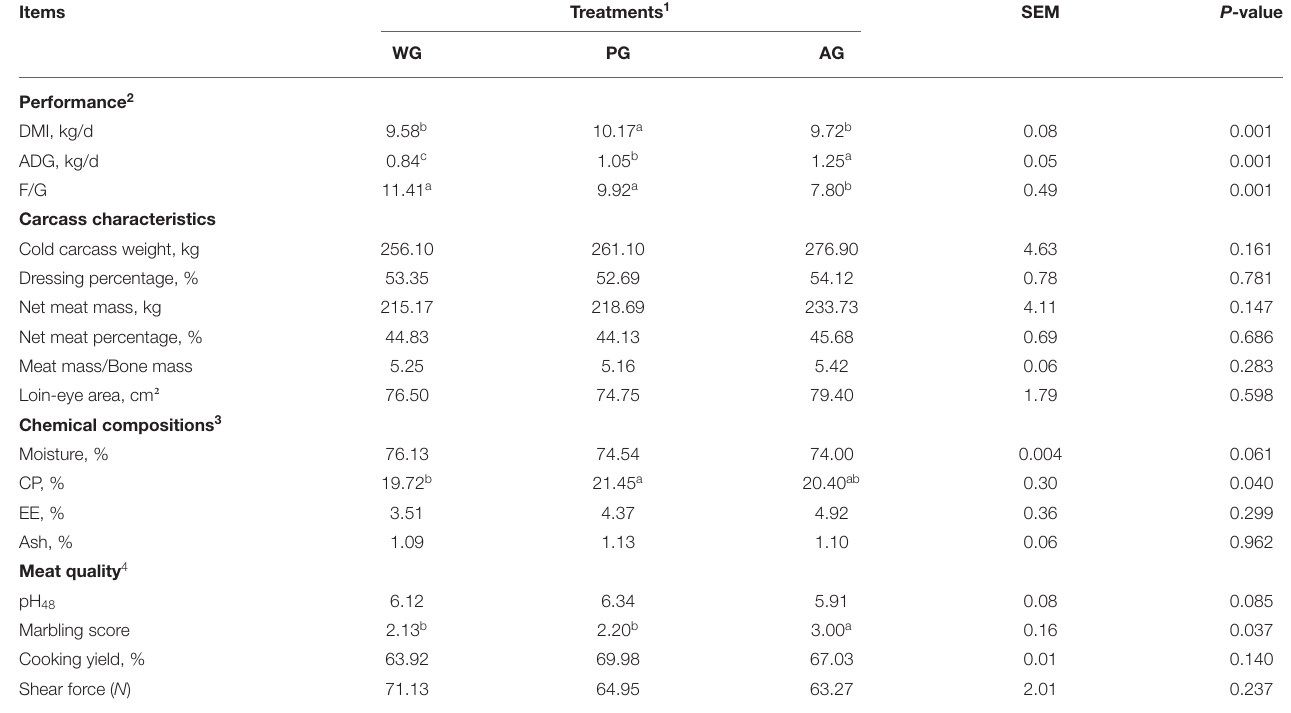
TABLE 3 | Performance, carcass characteristics, chemical compositions and meat quality of longissimus dorsi muscle in Simmental crossbred steers (DM%). Items Treatments 1 SEM P